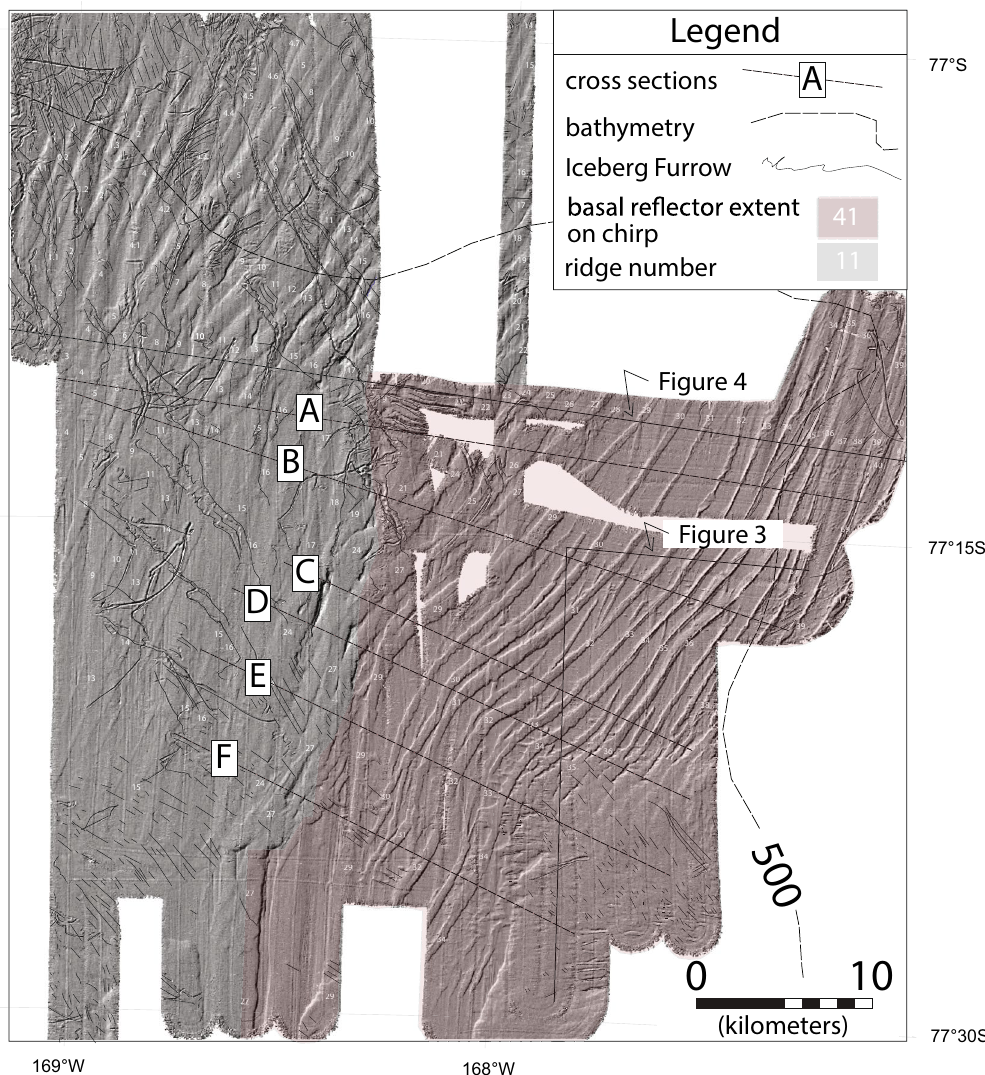
Figure 2. Hillshade multibeam swath bathymetry of the ridges on the middle continental shelf. The dashed line is the 500 m bathymetric contour from Davey and Nitsche 14 . The oldest ridge in the surveyed area is labeled 1. Thin black lines show the location of iceberg furrows. The shaded-area to the east demarcates where shallow- depth basal reflection is observed on chirp sonar.